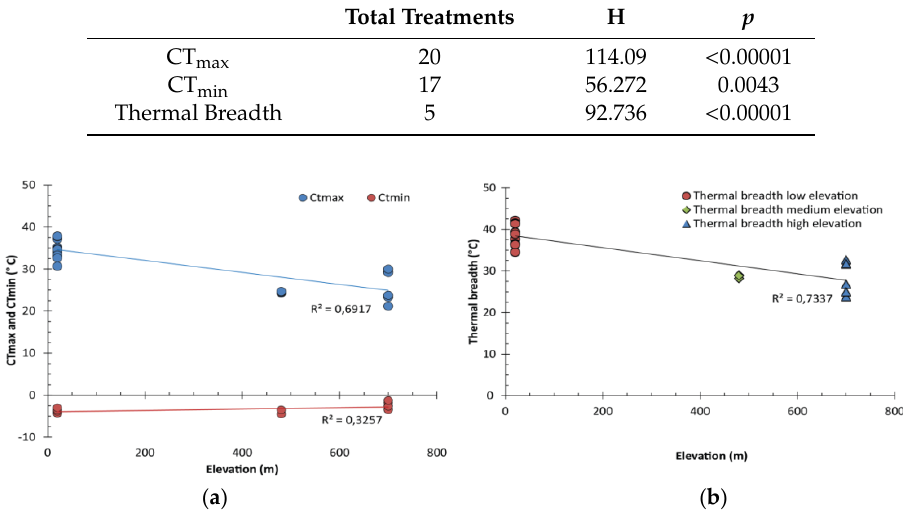
Figure 5. Critical thermal limits and thermal ranges of the studied taxa across the altitudinal gradient